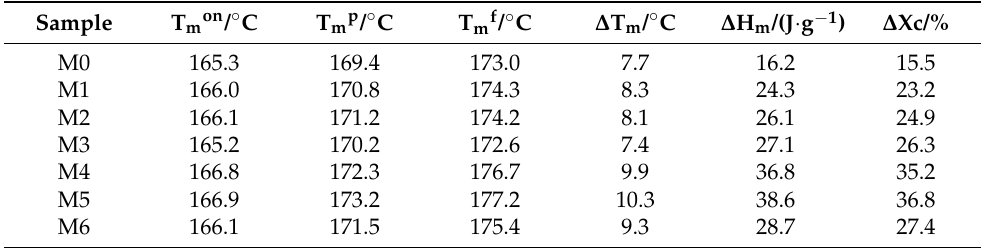
Table 2. DSC melting data of PVDF composited membranes with different amounts of mCNTs grafting single and diblock chains and membranes with oriented or unoriented mCNTs.